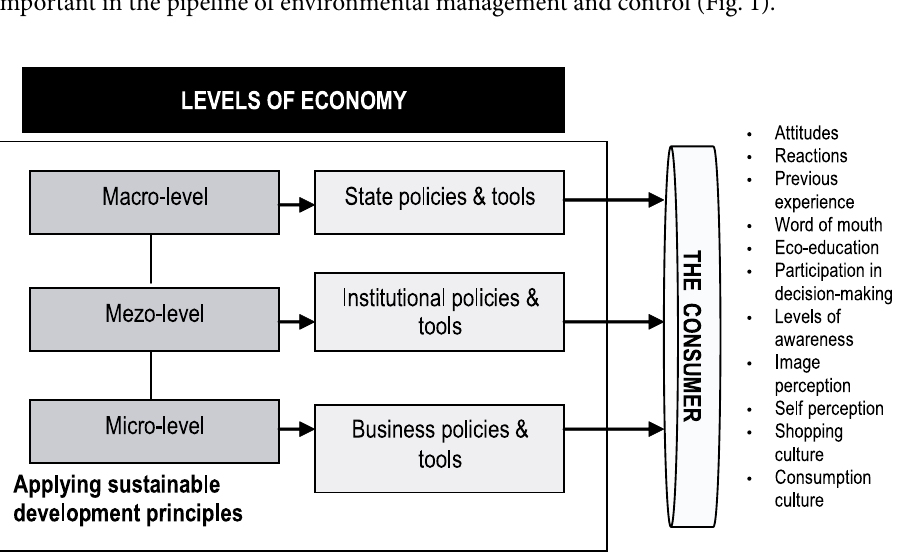
Fig. 1. Levels of applying sustainable development principles in the